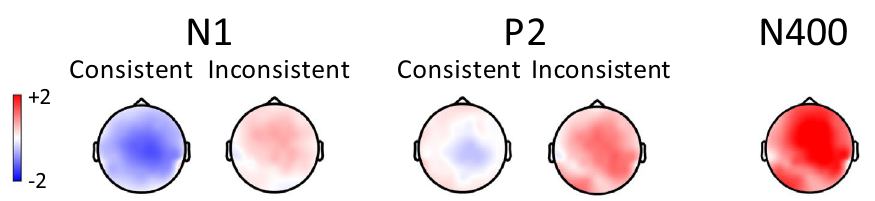
Figure 4. Topographic maps of the effect of Prime Type (related minus unrelated) for consistent and inconsistent words on the N1 and P2 and for all words on the N400.